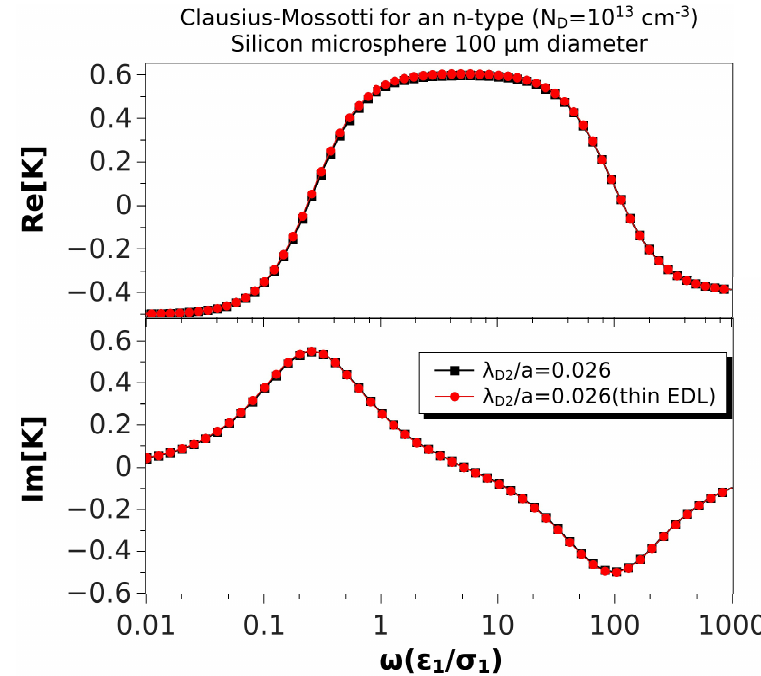
Figure 6. Real and imaginary parts of the Clausius–Mossotti factor versus nondimensional frequency for an n-type silicon ( N D = 10 13 cm − 3 ) microsphere (100 µ m) immersed in a KCl solution. The nondimensional Debye length in the particle is ¯ λ D 2 = 0.026. The results of the thin EDL approximation (Equation (35)) are compared with the exact solution, Equation (28).